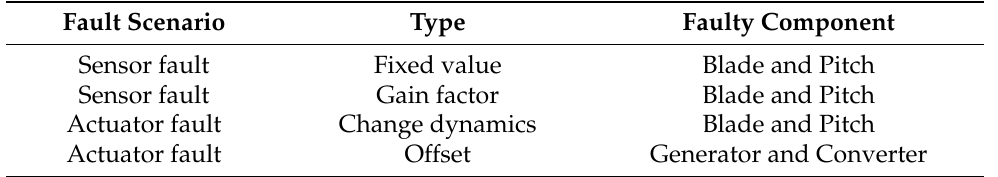
Table 1. Fault scenarios in the benchmark